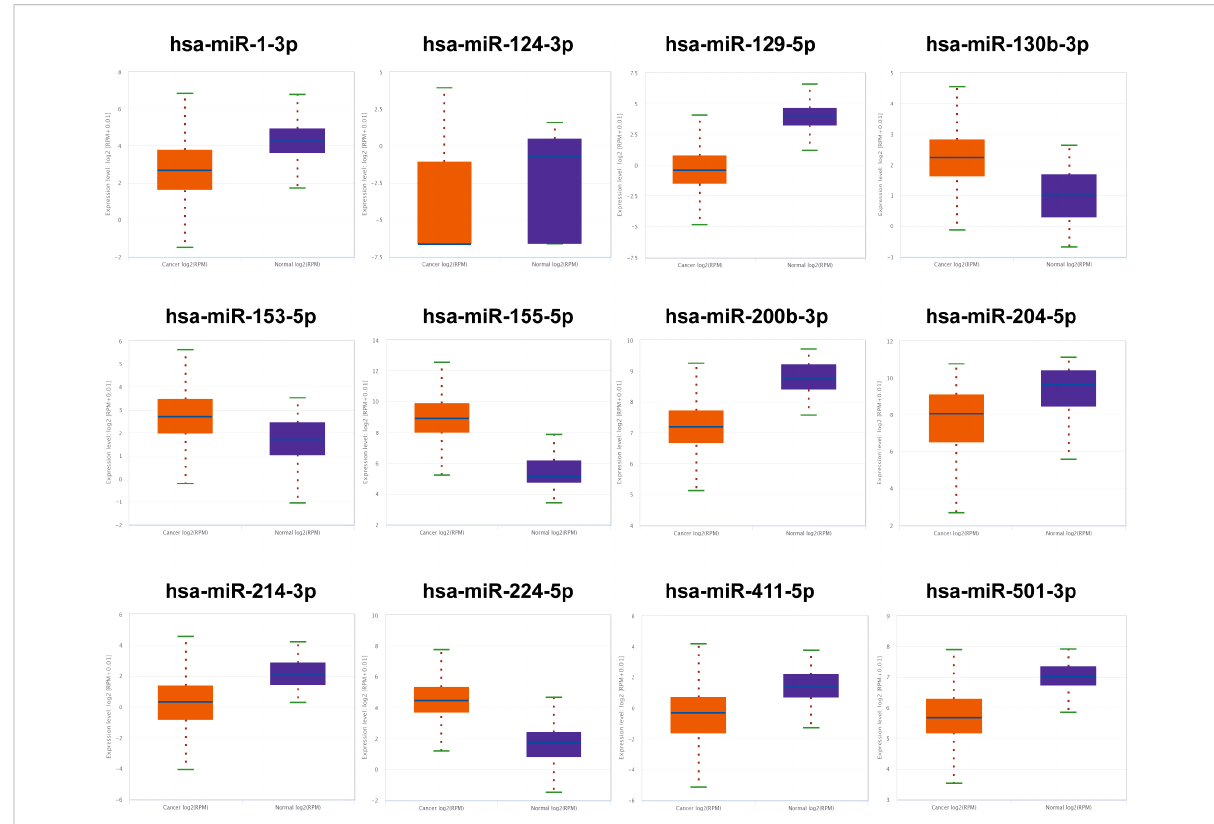
FIGURE 1 The 12 candidate miRNAs in ENCORI database. Based on the cutoff criterion: fold change (FC) >2 or < – 2 and p-value <0.01, 12 miRNAs were screened out as the initial